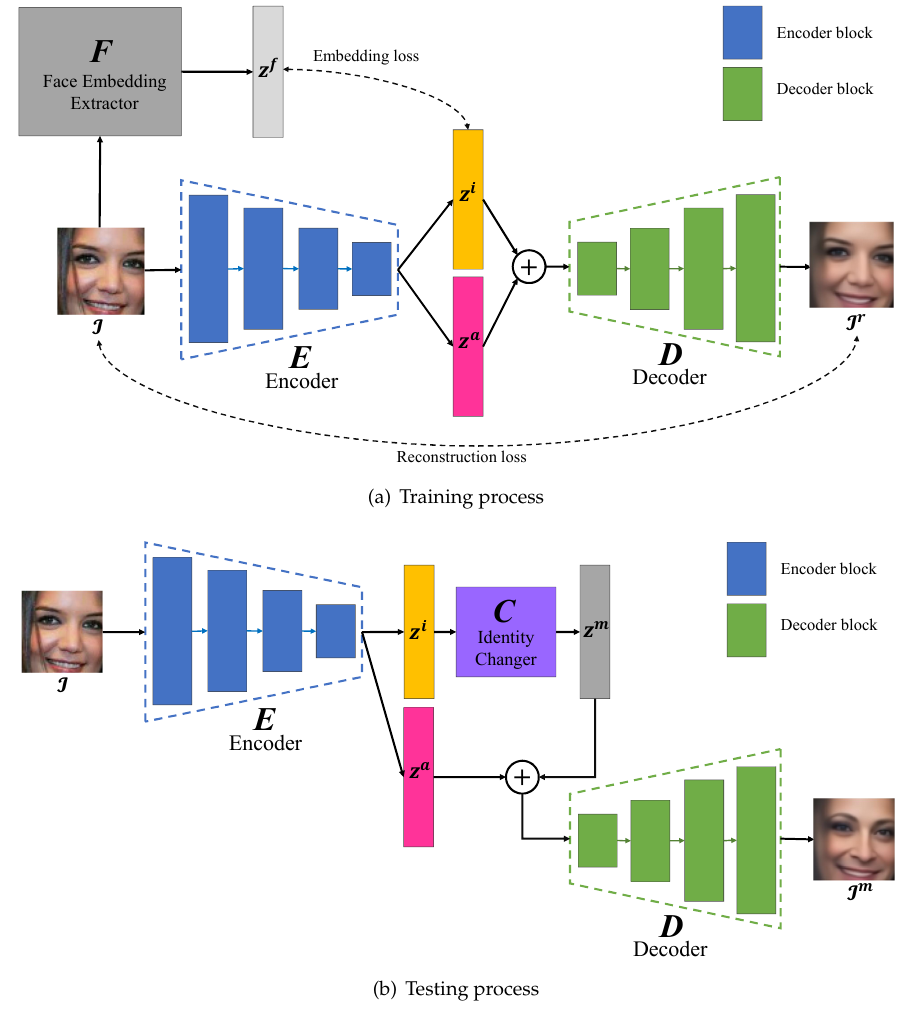
Figure 2. Overview of the proposed method: ( a ) an overview of the training process and ( b ) an overview of the testing process, where m is degrees of identity